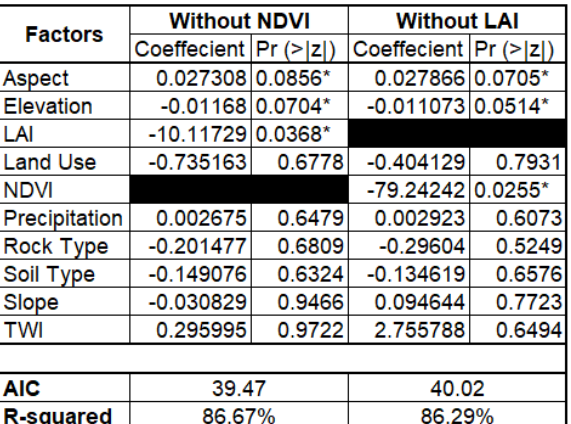
Table 2. The coefficients and probability scores of each factor for the two new